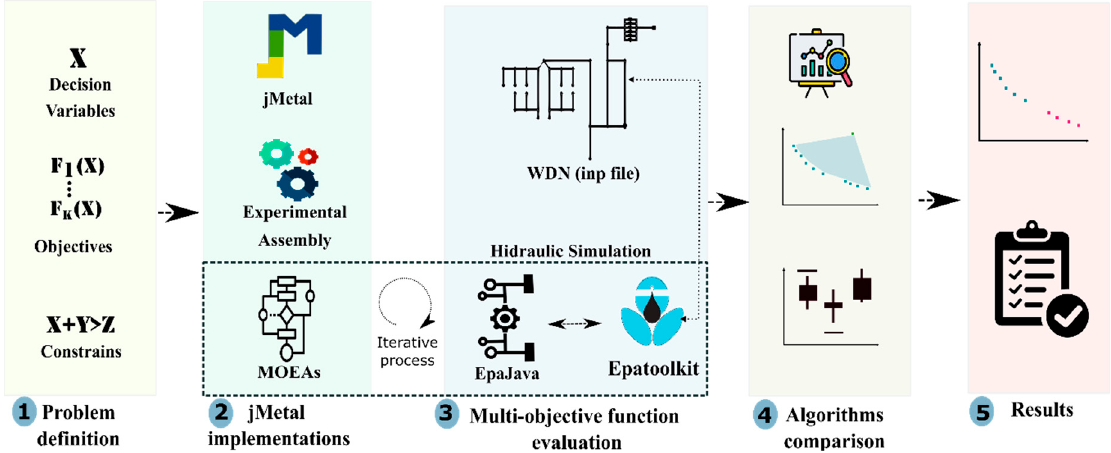
Figure 1. Workflow of a jHawanet project for a multi-objective optimization of a drinking water network.